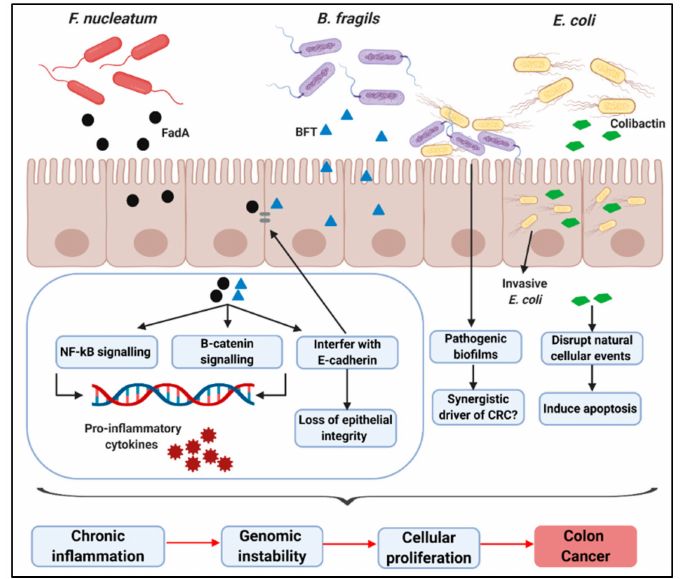
Figure 1. Overview of proposed mechanisms implicating principle CRC-associated bacterial pathogens in CRC development: Specific bacterial species may promote CRC through several mechanisms, such as the secretion of virulence factors by F. nucleatum (FadA) and B. fragilis (BFT), which activate NF-kB and β -catenin signaling pathways, leading to the development of pro-inflammatory cytokines which promotes pro-inflammatory microenvironments. Virulence factors may interfere with E-cadherin, a transmembrane protein essential for maintaining the epithelium cell layer, thus mediating the invasion of pathogenic bacteria. Cyclomodulin and genotoxin-producing E. coli (colibactin) may interfere